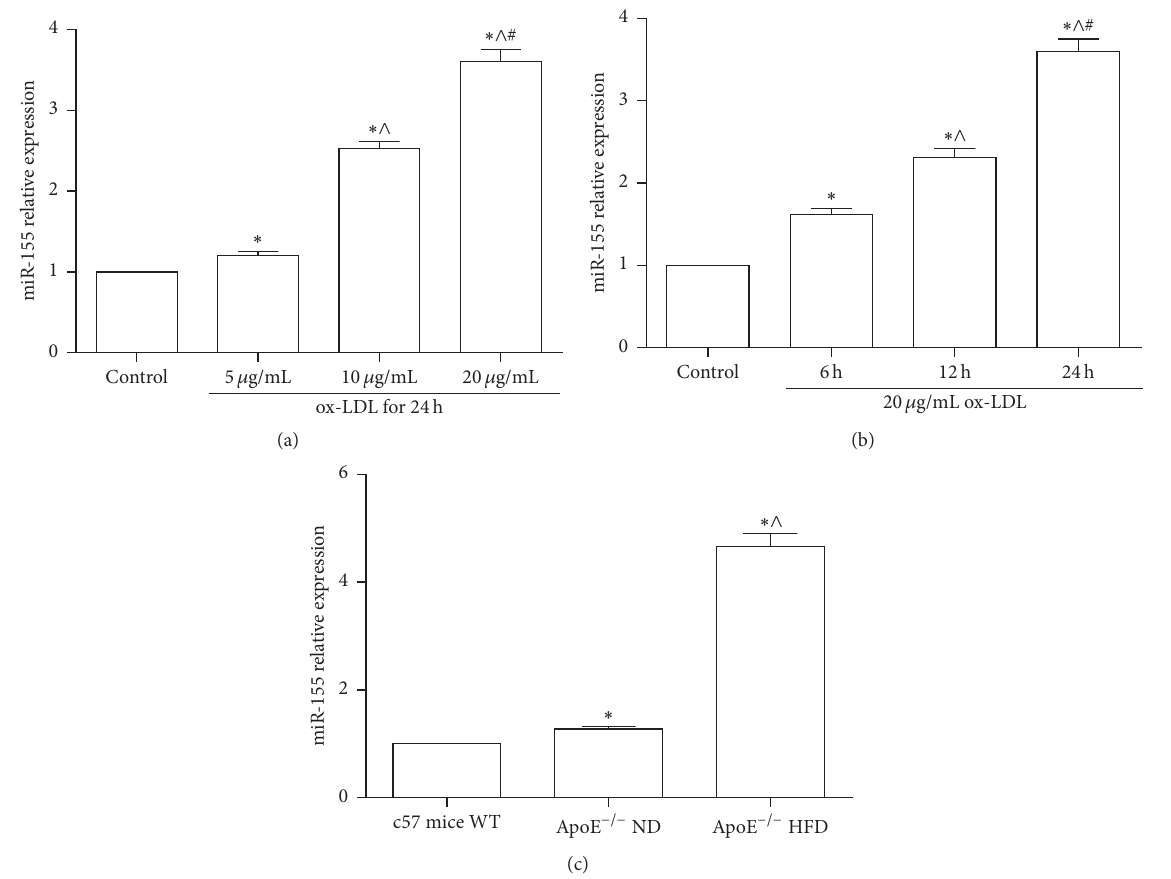
Figure 1: The relative expression of miR-155 in macrophages RAW264.7 cells and the aortic tissue of ApoE −/− mice. (a) qPCR analyzed the expression of miR-155 in RAW264.7 cells when macrophages were treated by ox-LDL for 24 h at the indicated dose: ∗ 𝑝 < 0.05 , relative to control, ∧ 𝑝 < 0.05 , relative to 5 𝜇 g/mL ox-LDL group, # 𝑝 < 0.05 , relative to 10 𝜇 g/mL ox-LDL group. (b) qPCR detected the level of miR-155 in macrophages, which were treated with 20 𝜇 g/mL ox-LDL at the indicated time: ∗ 𝑝 < 0.05 , relative to control, ∧ 𝑝 < 0.05 , relative to 6h group, # 𝑝 < 0.05 , relative to 12 h group. (c) Expression of miR-155 in aortic tissue of ND-fed wild-type (WT) c57 mice, ND-fed ApoE −/− mice (ApoE −/− ND), and HFD-fed ApoE −/− mice (ApoE −/− HFD) was determined by qPCR ( 𝑛 = 4 ): ∗ 𝑝 < 0.05 , relative to c57 mice WT; ∧ 𝑝 < 0.05 , relative to ApoE −/−